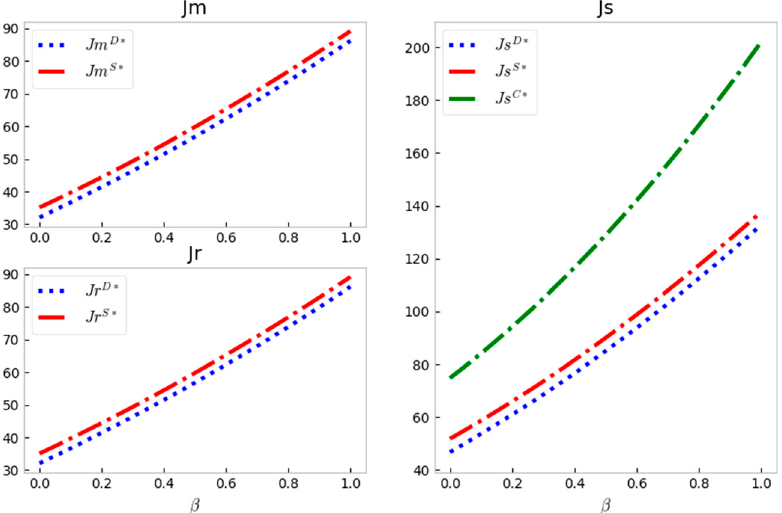
Figure 3. Coefficient β of impact of consumer ecological perception on goodwill impact on profit.